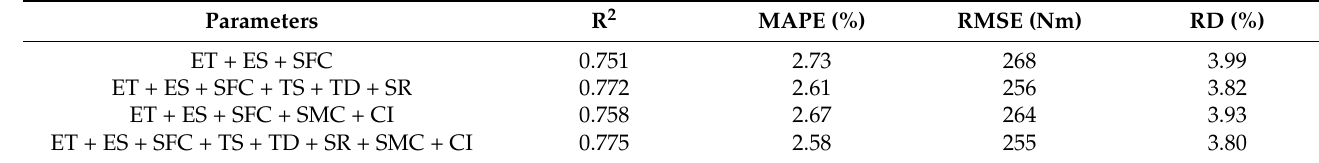
Figure 5. Results for MLR-based axle torque estimation model validation, comparing estimated values against measured axle torque: ( a ) as a function of the engine parameters; ( b ) as a function of the engine parameters and major tractor parameters; ( c ) as a function of the engine parameters and soil physical properties; and ( d ) as a function of the engine parameters, major tractor parameters, and soil physical properties. Table 4. Performance on the validation set for MLR-based axle torque estimation